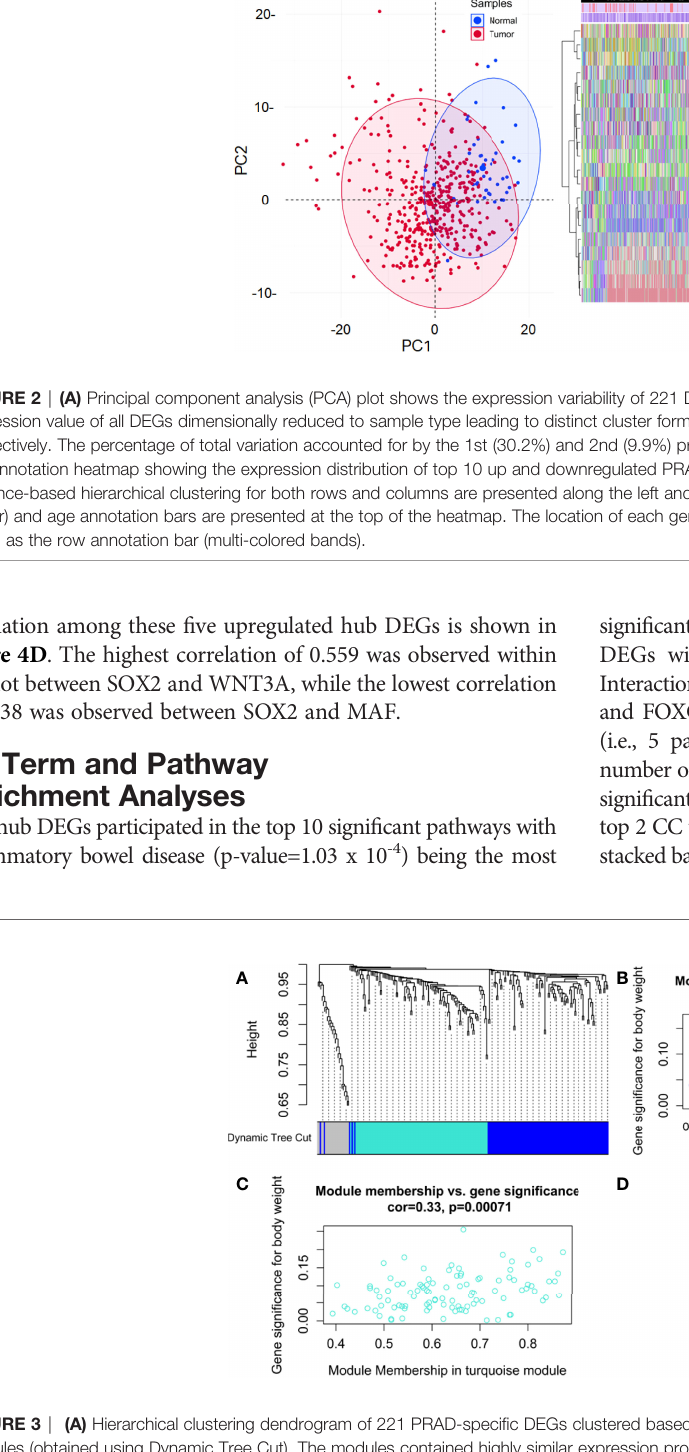
FIGURE 3 | (A) Hierarchical clustering dendrogram of 221 PRAD-speci fi c DEGs clustered based on the dissimilarity measure (dissTOM) along with 3 color-coded modules (obtained using Dynamic Tree Cut). The modules contained highly similar expression pro fi les with the following sizes: turquoise (102), blue (97), and grey (22). Scatterplots show a signi fi cant (p-value <0.05) correlation of Gene signi fi cance (GS) for weight with module membership (MM) in (B) blue and (C) turquoise modules. (D) Topological Overlap Matrix (TOM) plot of the weighted gene co-expression network representing TOM among blue and turquoise module genes. Hierarchically clustered gene dendrograms and module assignments are presented along the top and left sides of the plot. Lighter and darker shades signify lower and higher overlap among the genes. Dark-colored blocks along the diagonal represent